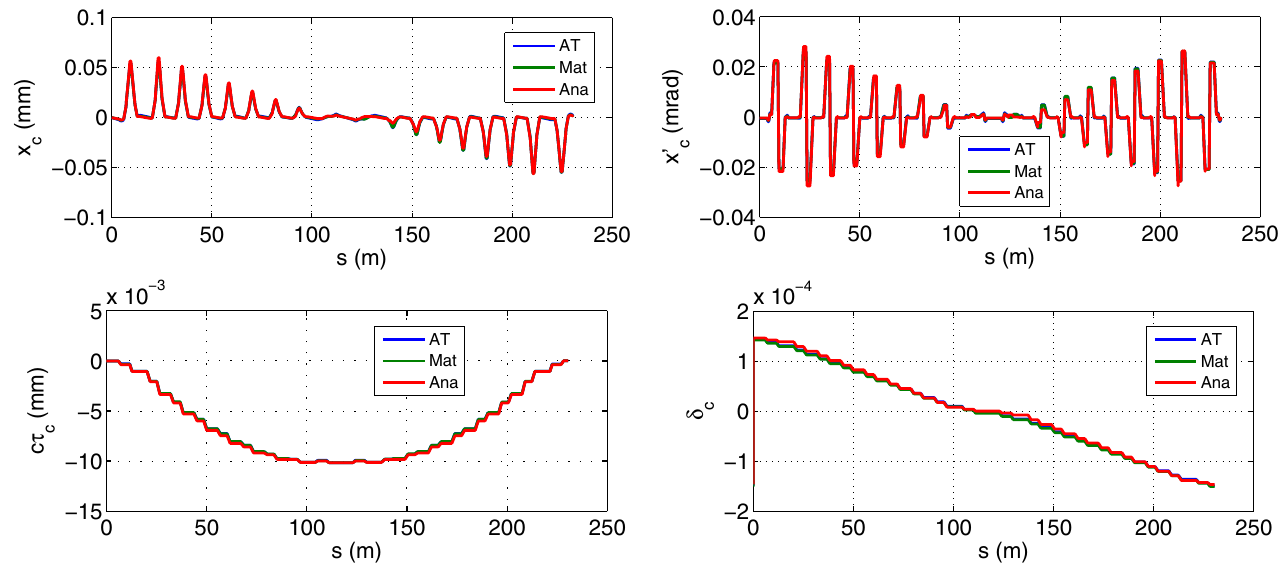
FIG. 5. (Color) The SBC-induced closed-orbit changes calculated in three different ways for the SPEAR3 ring. The changes to x c(cid:2) , and (cid:3) are shown. The three curves are from AT (AT), matrix inversion (Mat), and the analytic solution (Ana), c c